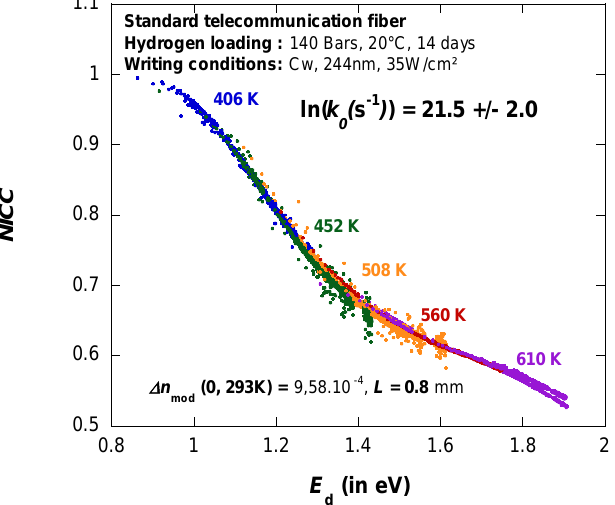
= k . T .ln( k t ) (in eV), i.e. , the master curve. k d B 0